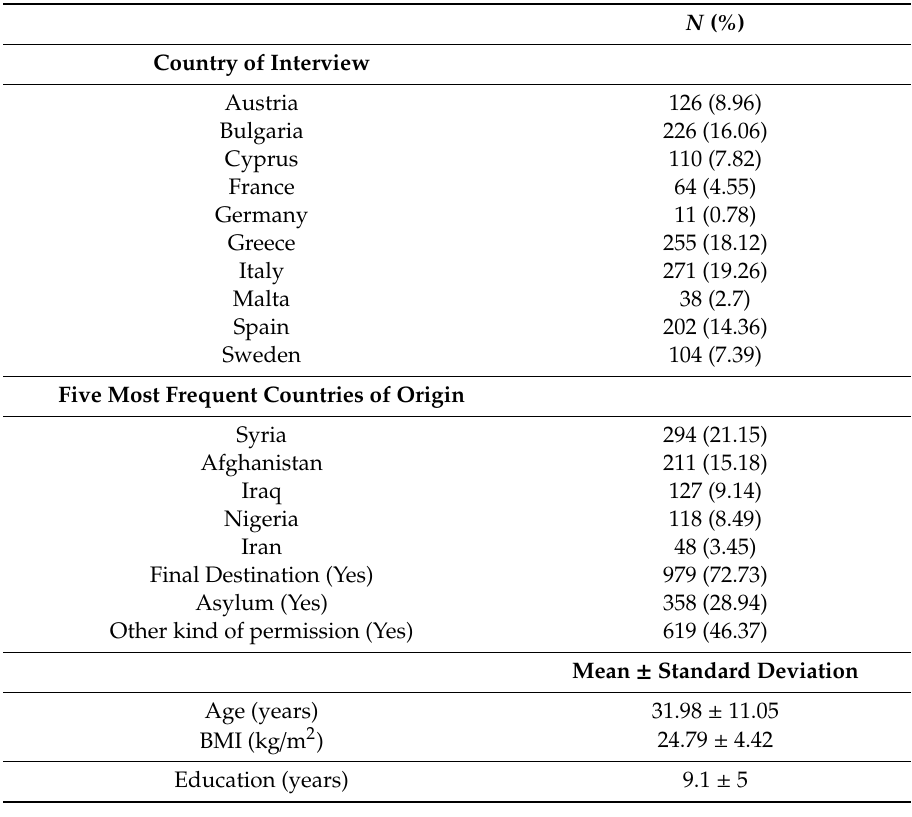
Table 1. Characteristics of the total sample of migrants and refugees (N =